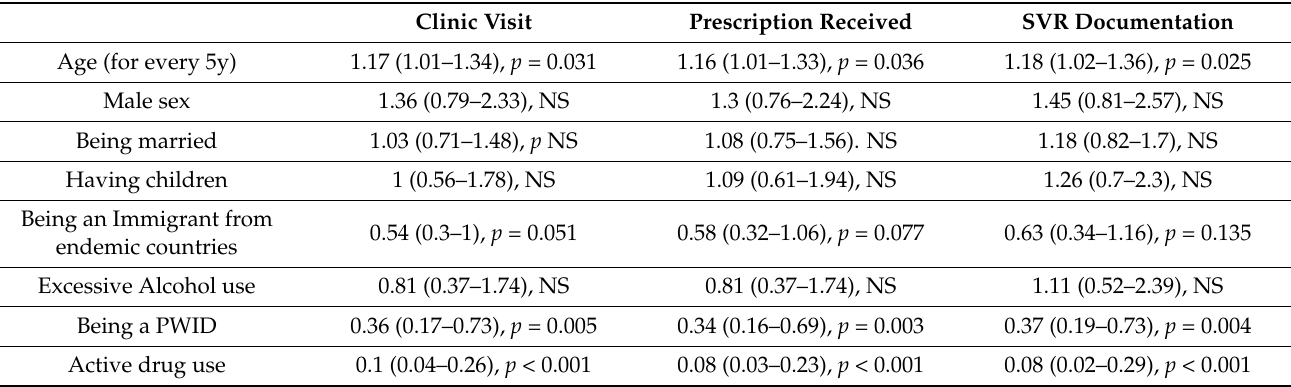
Table 3. Univariate analysis.